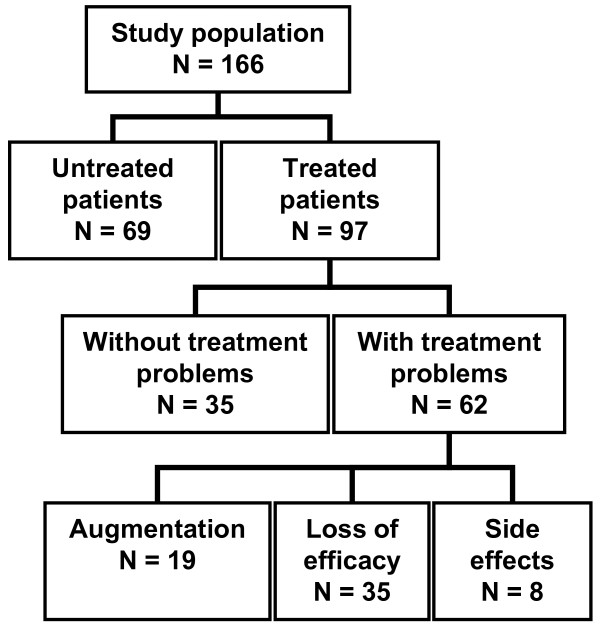
Flow diagram of study population.